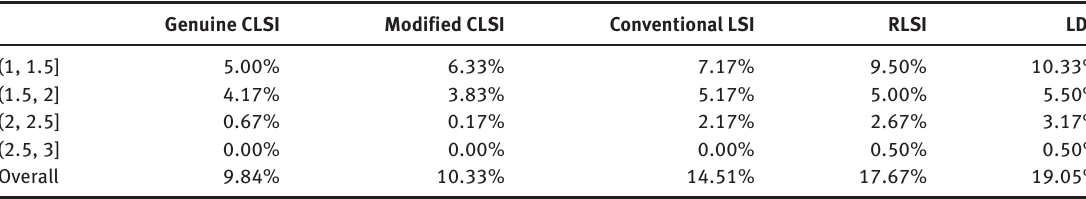
Table 9: Comparisons of Scoring